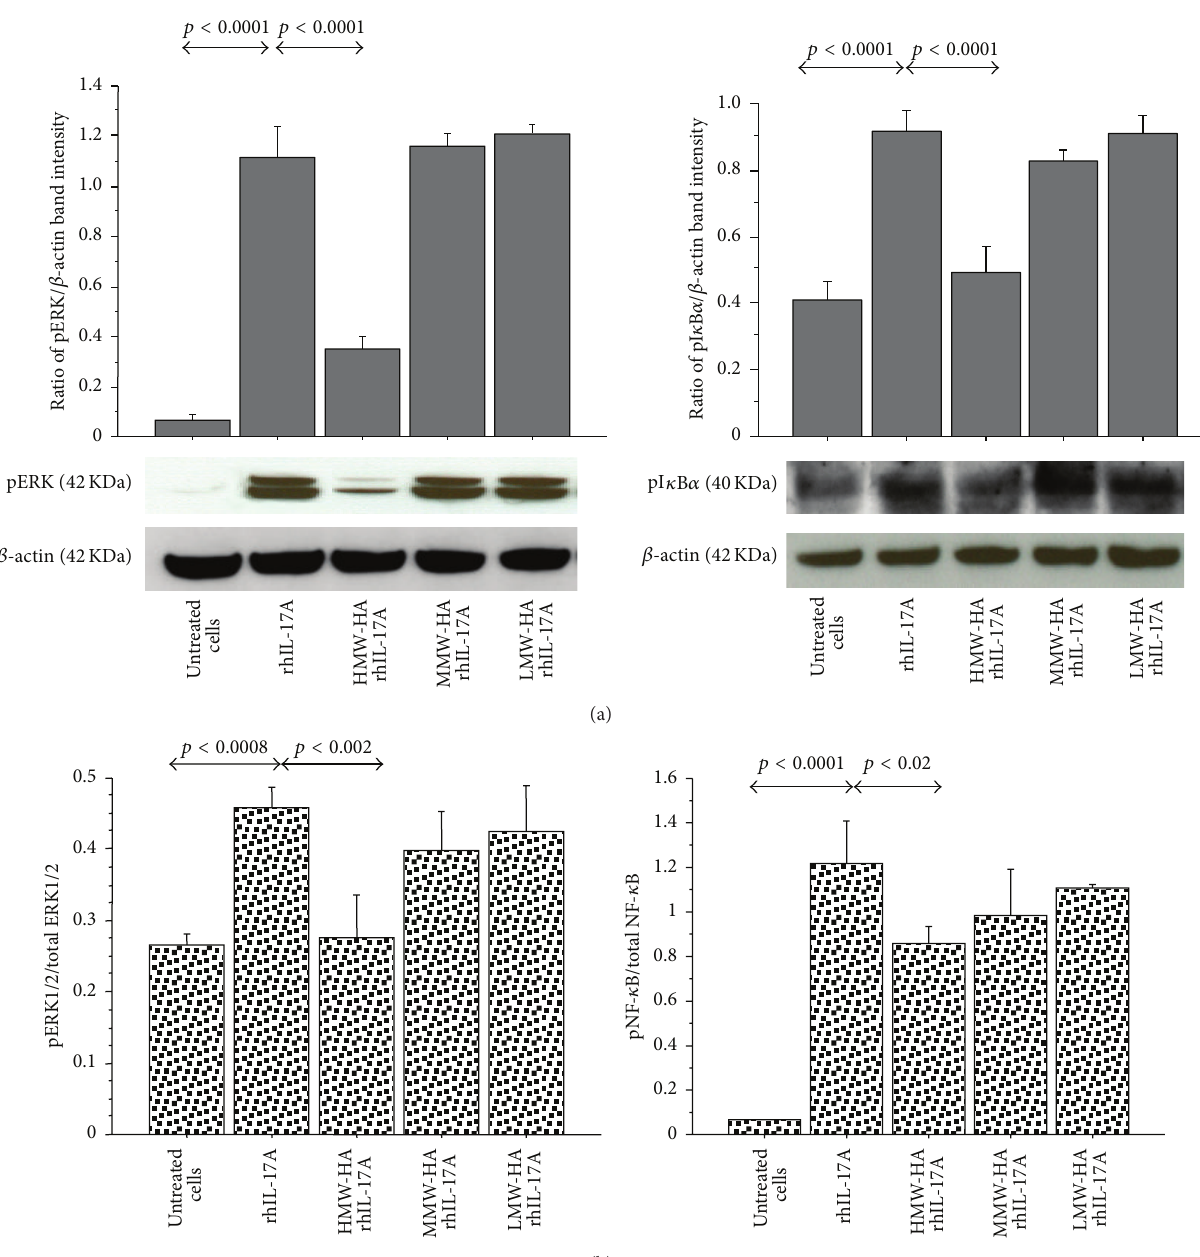
Figure3:EffectofHMW-HA,MMW-HA,andLMW-HAonERK1/2andNF- 𝜅 BsignalpathwayinRPMI2650cellsstimulatedwithrhIL-17A. The cells were preincubated with HMW-HA (100 𝜇 g/mL), MMW-HA (100 𝜇 g/mL), and LMW-HA (100 𝜇 g/mL) for 1h and then stimulated with rhIL-17A (20 ng/mL) for 30min; (a) pERK and pI 𝜅 B 𝛼 protein expression were evaluated in the cell lysates by western blot. The bars represent the ratio of band intensity and 𝛽 -actin of 3 separate experiments. Representative gel images of pERK, pI 𝜅 B 𝛼 , and 𝛽 -actin are shown; (b) the activation of ERK1/2 and NF- 𝜅 B for each experimental condition was tested for the pERK1/2/total ERK1/2 ratio and pNF- 𝜅 B/total NF- 𝜅 B ratio by ELISA and normalized for protein content. ANOVA with Fisher’s test correction was used for the analysis of the data. 𝑝 < 0.05 was statistically